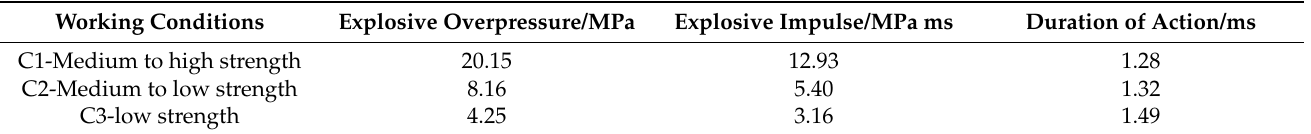
Table 3. Different blast load conditions.